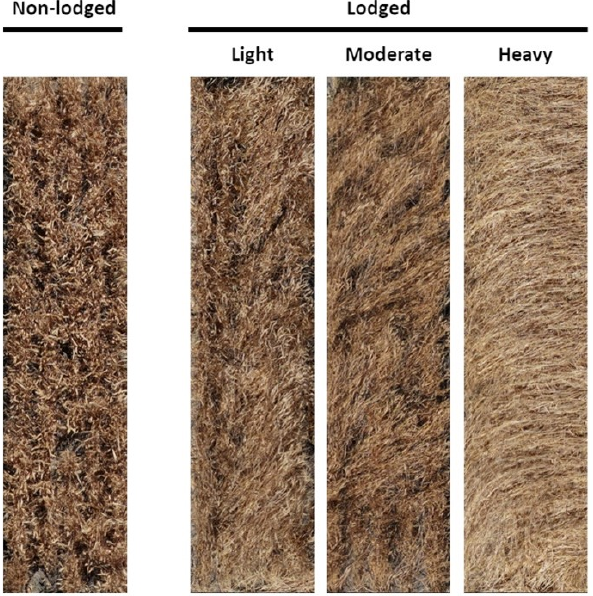
Figure 3. Experimental workflow for wheat lodging assessment.